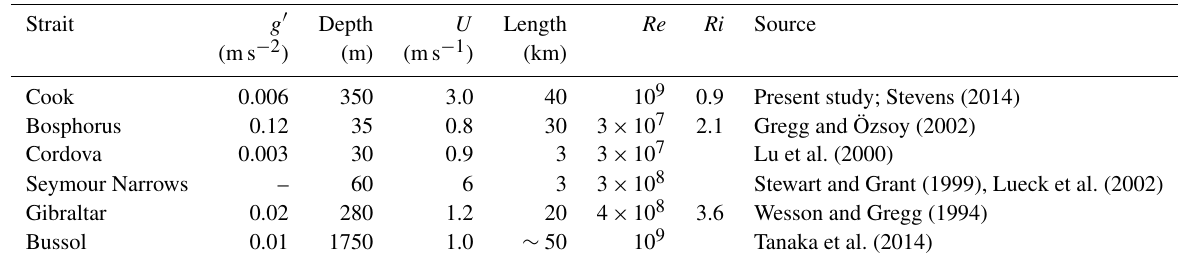
Table 1. Comparison of approximate representative strait scales (extended from Helfrich, 1995; Hogg et al., 2001).